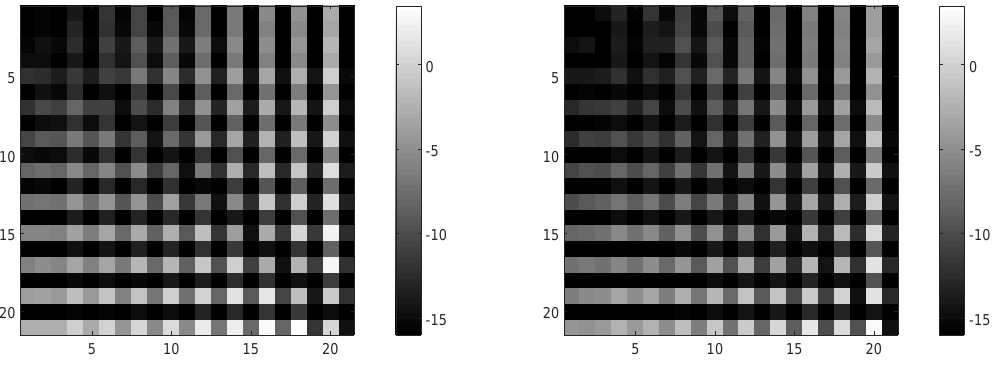
V 20 − I for the two-and four-term recurrence 20